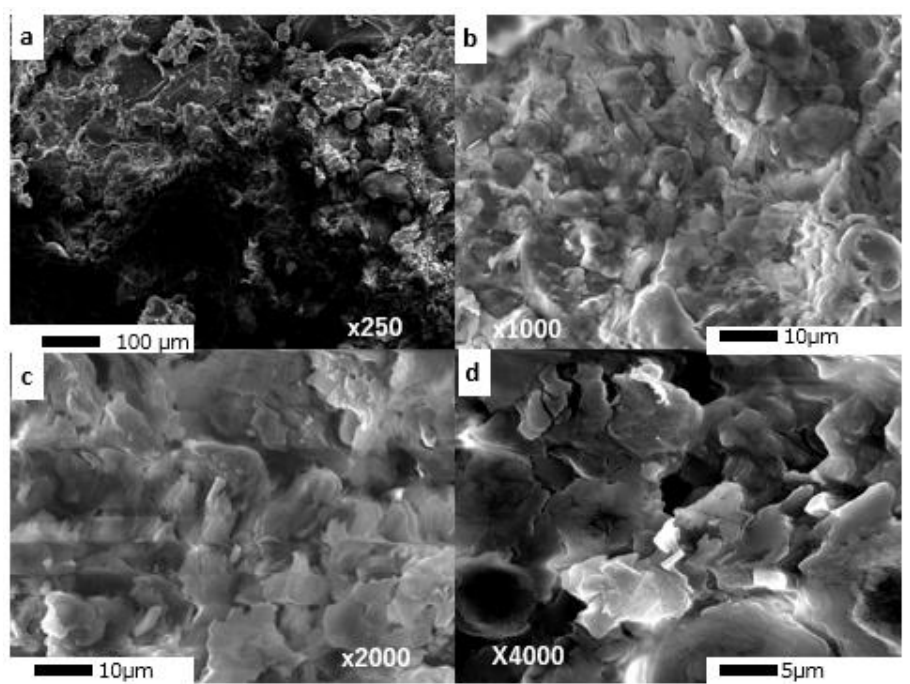
Figure 5. Scanning electron microscopy of almond bark at different magnifications: ( a ) 250×, ( b ) 1000×, ( c ) 2000× and ( d ) 4000×.